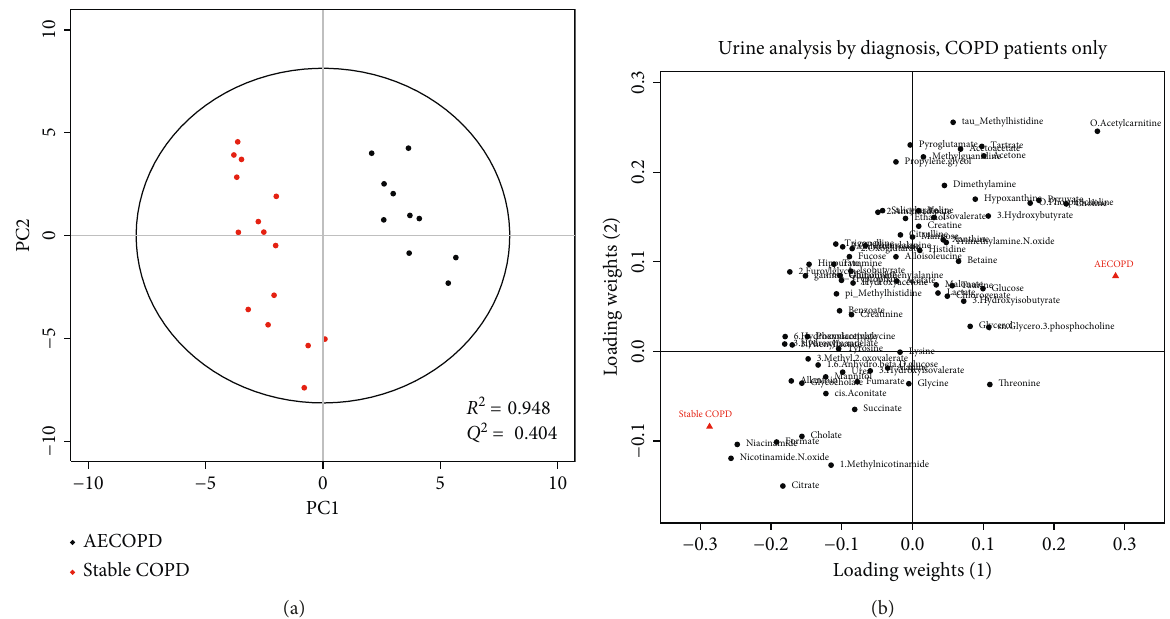
Figure 4: PLS-DA score plots (a) and loading plots (b) of urine samples drawn from patients with stable COPD (red) or AECOPD (black). Each circle represents a urine sample. The two groups are well separated in the score plots. The loading plot shows how the profiled metabolites contribute to the separation seen in the scores. The model is not statistically significant ( p (cid:136) 0 . 929), but the fit is quite good ( R 2 (cid:136) 0.948), as is the predictive value ( Q 2 (cid:136) 0.404). This indicates that the model is overfit and suffers from a low sample